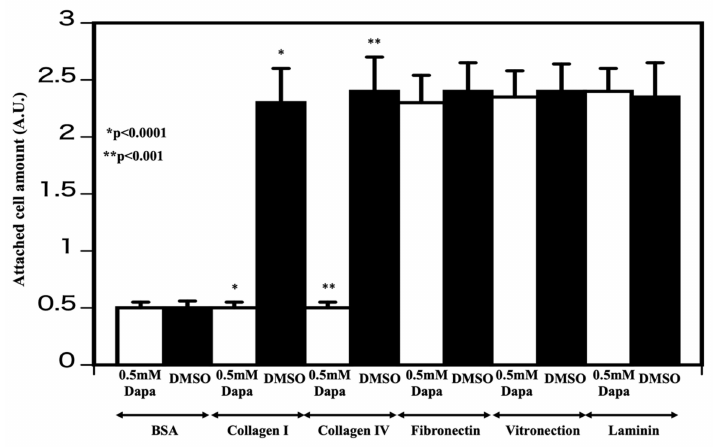
Figure 4. Determination of adhesion molecule a ff ected by dapagliflozin HCT116 cells were incubated with either vehicle (DMSO) or 0.5 mM dapagliflozin for 35 min and added to tissue culture dishes coated with bovine serum albumen (BSA), collagens I and IV, fibronectin, vitronectin, or laminin. After washing, the number of cells remaining and attached to the substratum was determined as described in the Experimental procedures section (n = 3, DMSO-treated cells vs. cells treated with 0.5 mM dapagliflozin * p < 0.0001, ** p < 0.001). The open column represents cells treated with 0.5 mM dapagliflozin and the closed column represents DMSO-treated cells. The experiments were conducted independently in